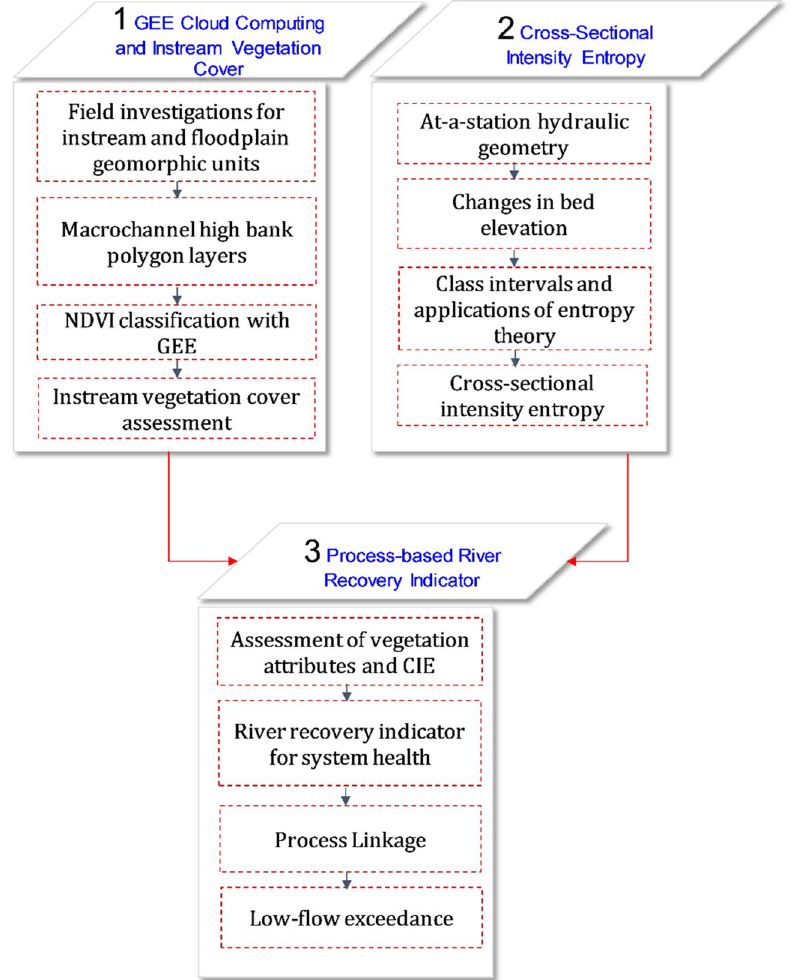
Figure 3. The methodological flowchart for evaluation of process-based recovery